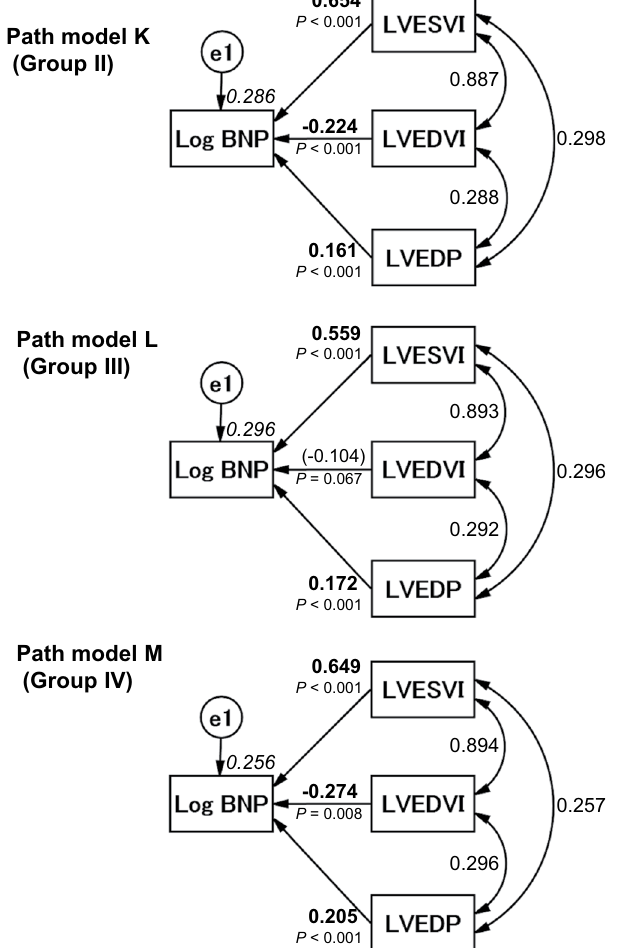
Figure 5. Path models K–M. The paths are displayed with coefficients that indicate the standardized coefficient of the regressing independent variable on the dependent variable of the relevant path in the subtype groups (path models K–M, LVESVI and/or LVEDVI and/or LVEDP to Log BNP) of Groups II (path model K), III (path model L) and IV (path model M). These variables are the standardized regression coefficients [direct effect; not significant coefficients (inside round brackets)], squared multiple correlations [on the upper right side of rectangles (in italics)] and the correlations between each of the variables. Other variables used in the covariance structure analysis are shown in Supplemental Tables 12, 13, and 14. BNP, B-type natriuretic peptide; LVESVI, left ventricular end-systolic volume index; LVEDVI, left ventricular end-diastolic volume index; LVEDP, left ventricular end-diastolic pressure; and e, extraneous